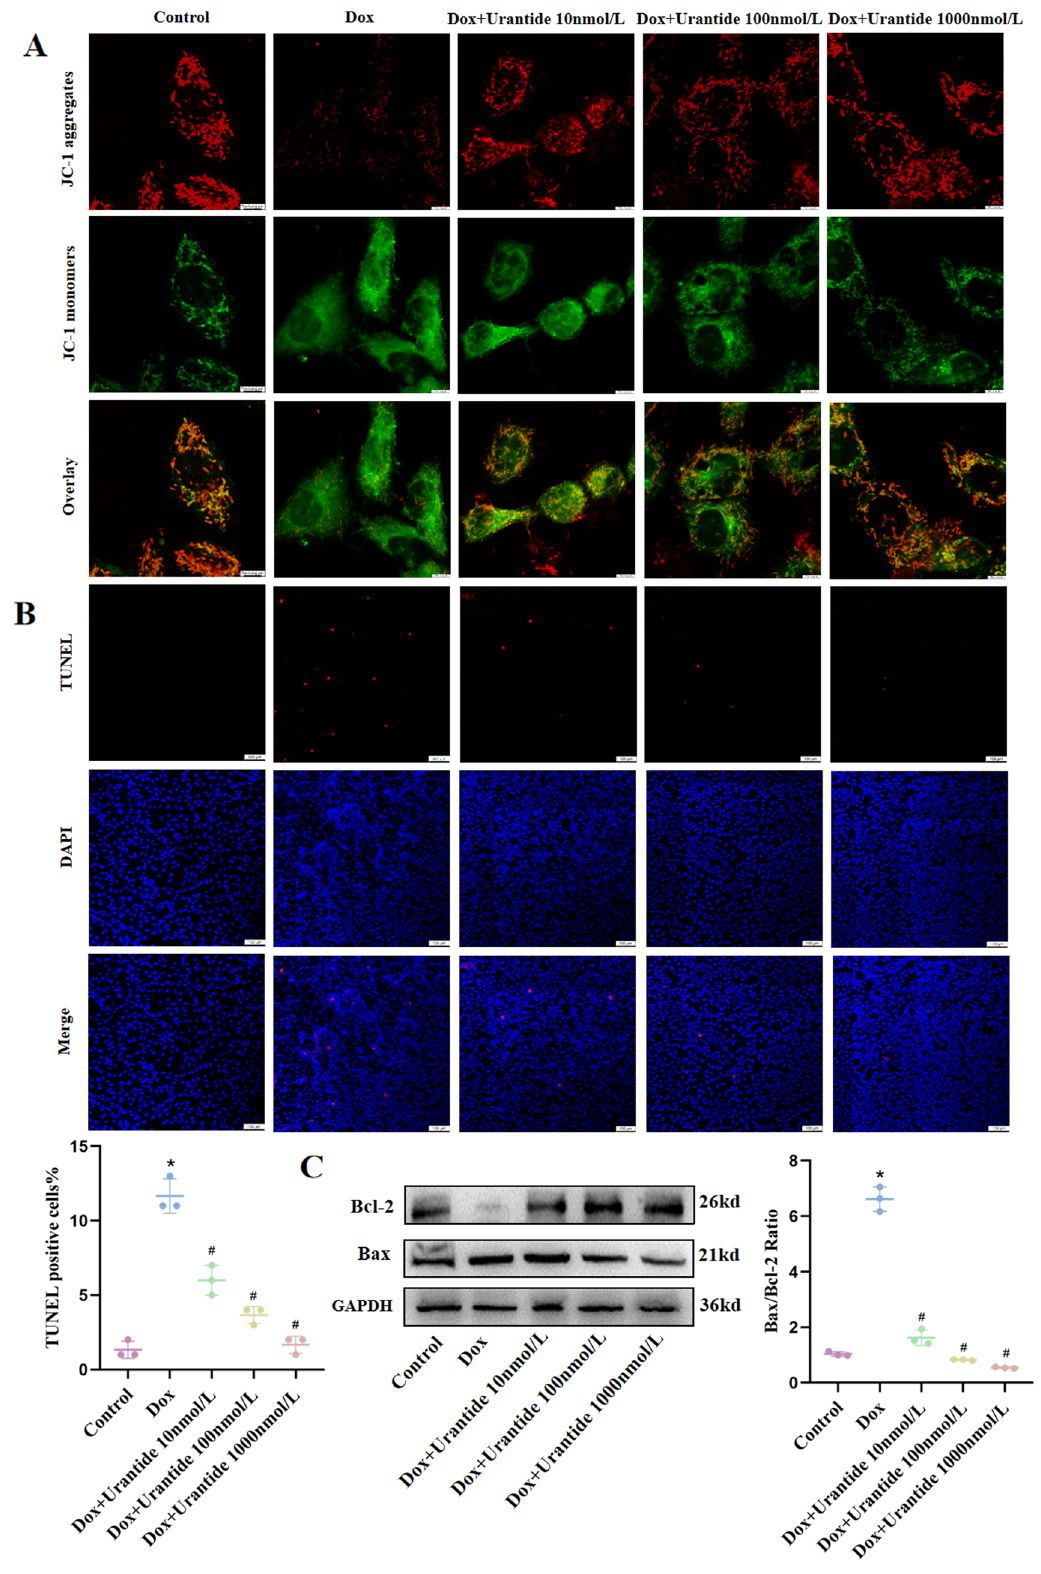
Figure 6. Urantide attenuates DOX-induced apoptosis in vitro. ( A ) Effects of Urantide (10 nmol/L, 100 nmol/L, 1000 nmol/L for 24 h) on DOX (5 μmol/L for 24 h) ‐ induced dissipation of mitochondrial membrane potential measured in H9C2 cells loaded with JC ‐ 1 using fluorescence microscopy. ( B ) Representative images of TUNEL staining of H9C2 cells. ( C ) The relative expression of Bcl ‐ 2 and Bax in H9C2 cells with or without Urantide treatment under DOX stimulation. *P < 0.05, vs. the control; # P < 0.05 vs. the